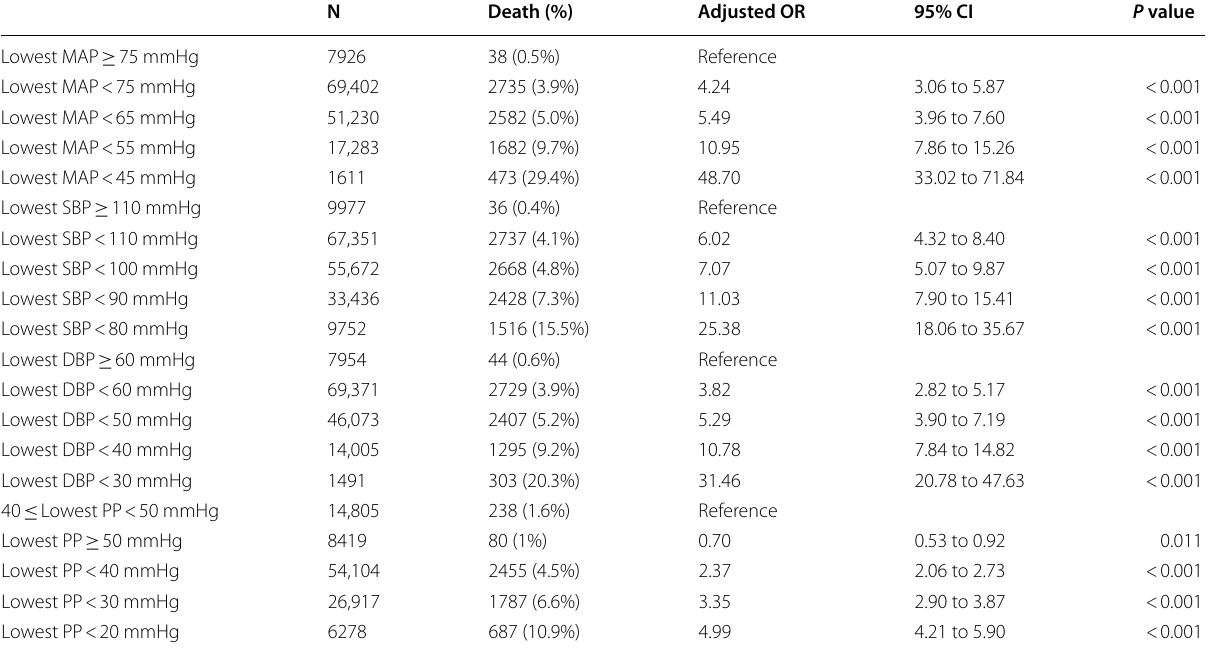
The entire population was categorized into subgroups using several thresholds for each blood pressure component. MAP DBP 60 mmHg, and 40 PP < 50 mmHg were selected as reference groups, respectively. Multivariable logistic regression was conducted to quantitatively evaluate ≥ ≤ the risk of ICU mortality for different thresholds. Age, BMI, APACHE IVa score, ethnicity, admission type, admission year, hospital bed size, hemoglobin, albumin, WBC, BUN, and lactate were selected as covariates. The effect of hypotension exposure on ICU mortality in the lowest pressure category was smaller in PP compared to MAP, SBP, and